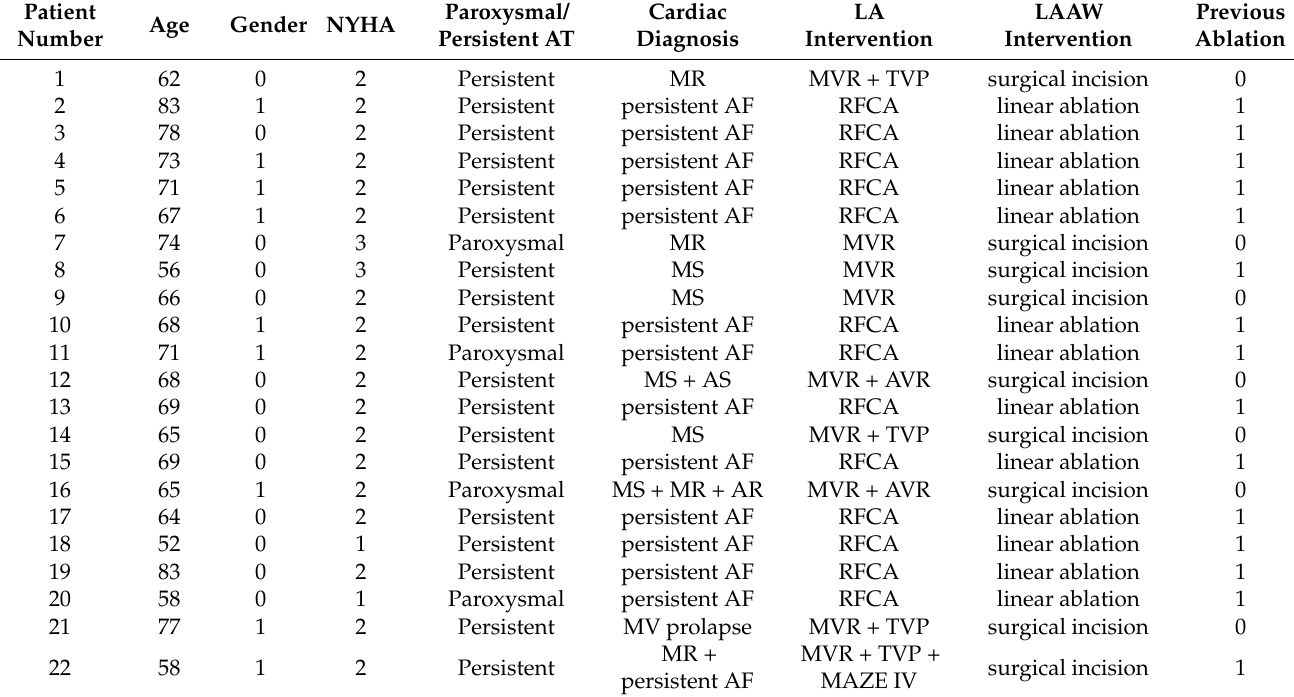
Table 1. Baseline characteristics of the